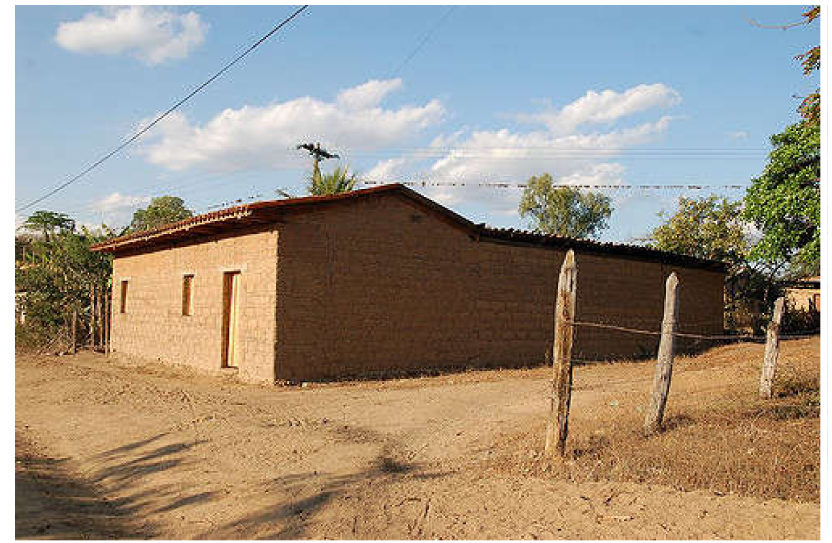
Figure 6. Adobe houses rebuilt following the local tradition in Ocotal,